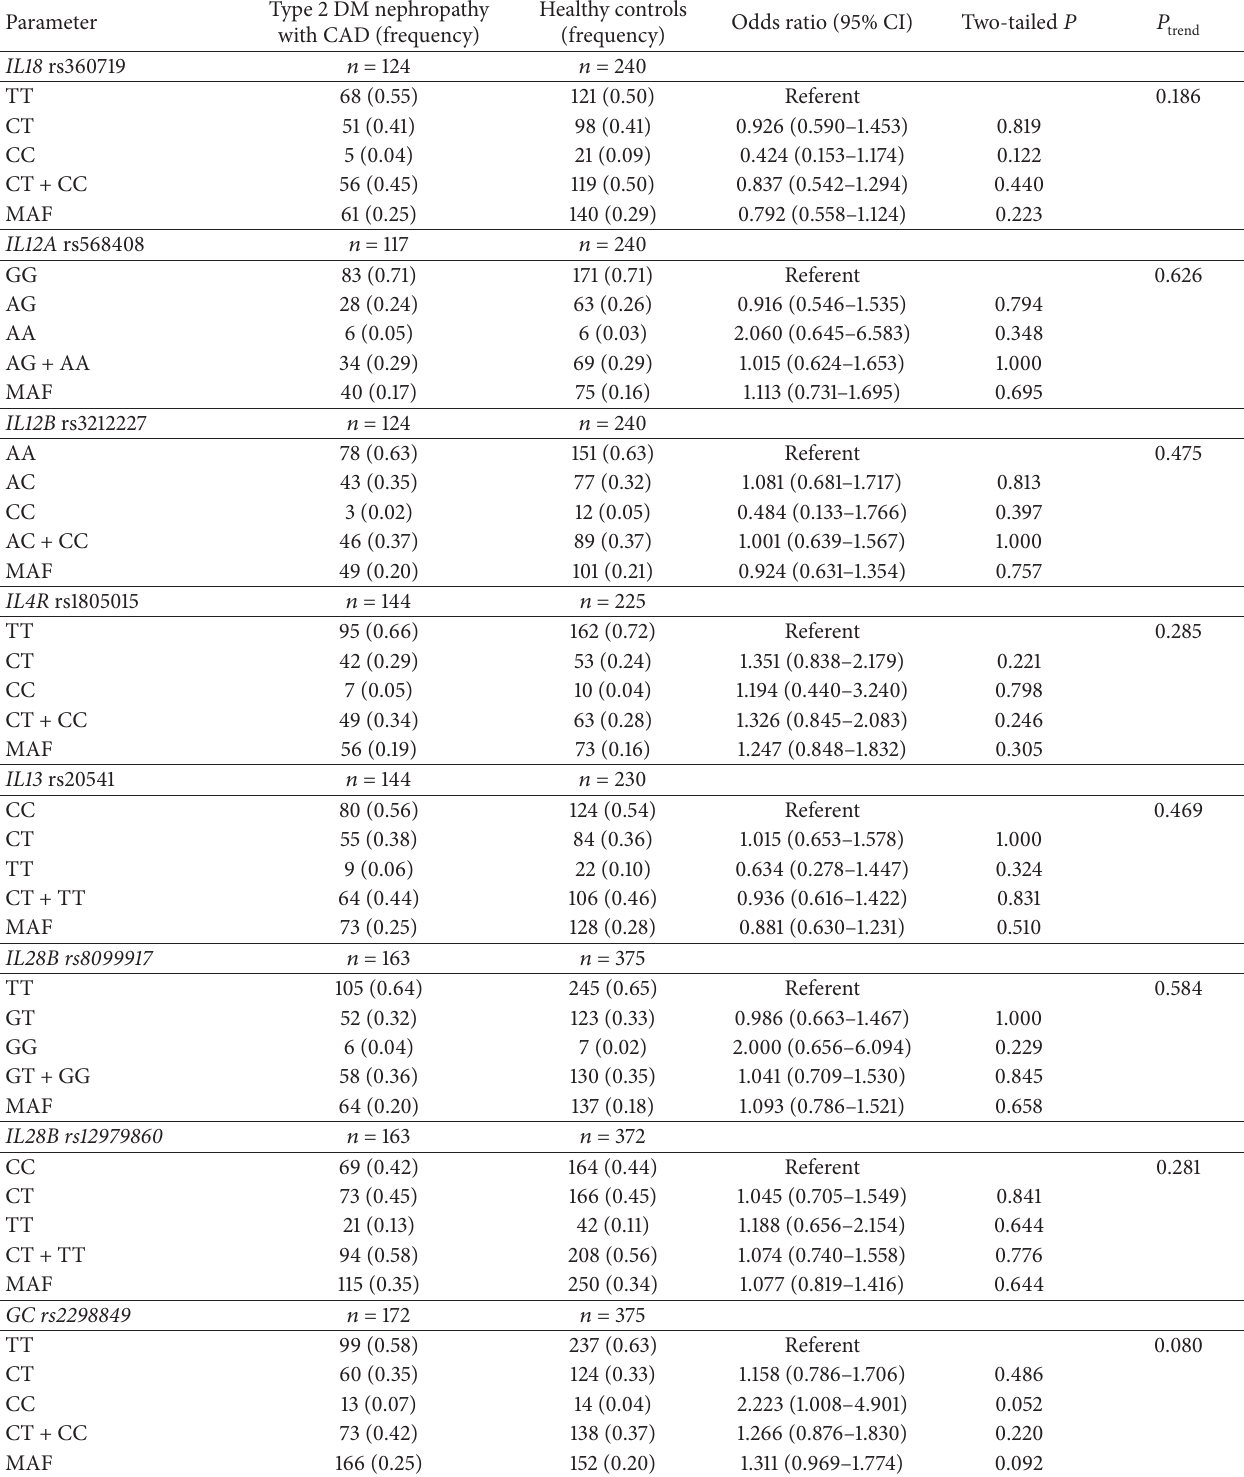
Table 8: Comparison of the distribution of polymorphic variants of tested genes between type 2 DM nephropathy patients with diagnosis of CAD and healthy